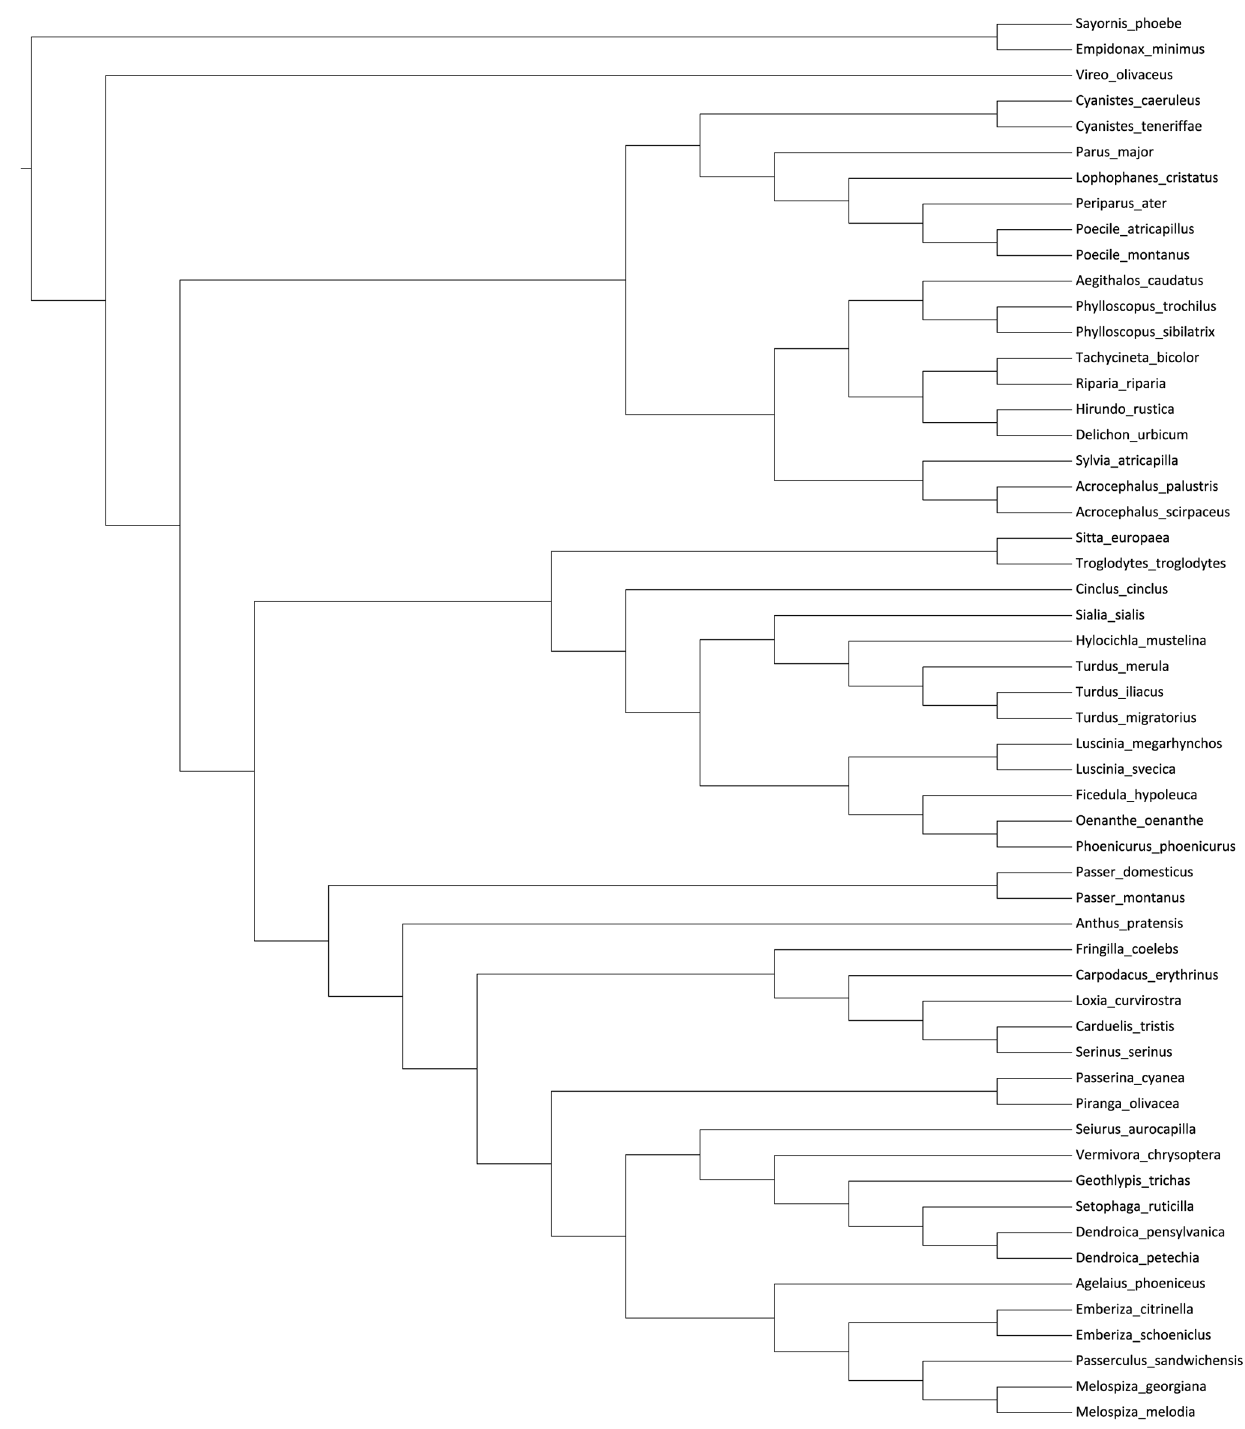
Figure 1. Phylogeny of study species. The figure illustrates the phylogenetic relationships among the 55 study species. The tree was derived from the most recent advances in avian molecular phylogenetics, with emphasis on studies using multiple genes and broad taxonomic coverage. Explanations and references to the different nodes are given in Materials and Methods. doi:10.1371/journal.pone.0013456.g001 Turdidae and Muscicapidae, consistent with the results of Jønsson species. The relationships among the Muscicapidae (5 spp.) follow Zuccon and Ericson [39] and Sangster et al. [40]. and Fjeldsa˚ [36] and Treplin et al. [29]. The phylogenetic relationships within Turdidae (5 spp.) follow Voelker and Klicka The phylogenetic relationships among families within in the [37] for the genera and Voelker et al. [38] for the three Turdus Passeroidea is still poorly resolved, and contrasting topologies exist